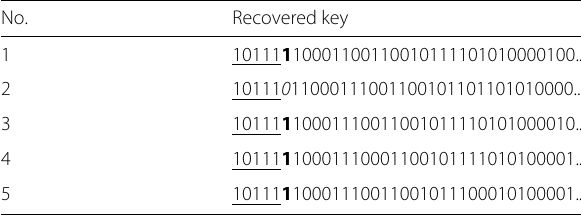
Table 2 Bit-wise key recovery over five partial keys